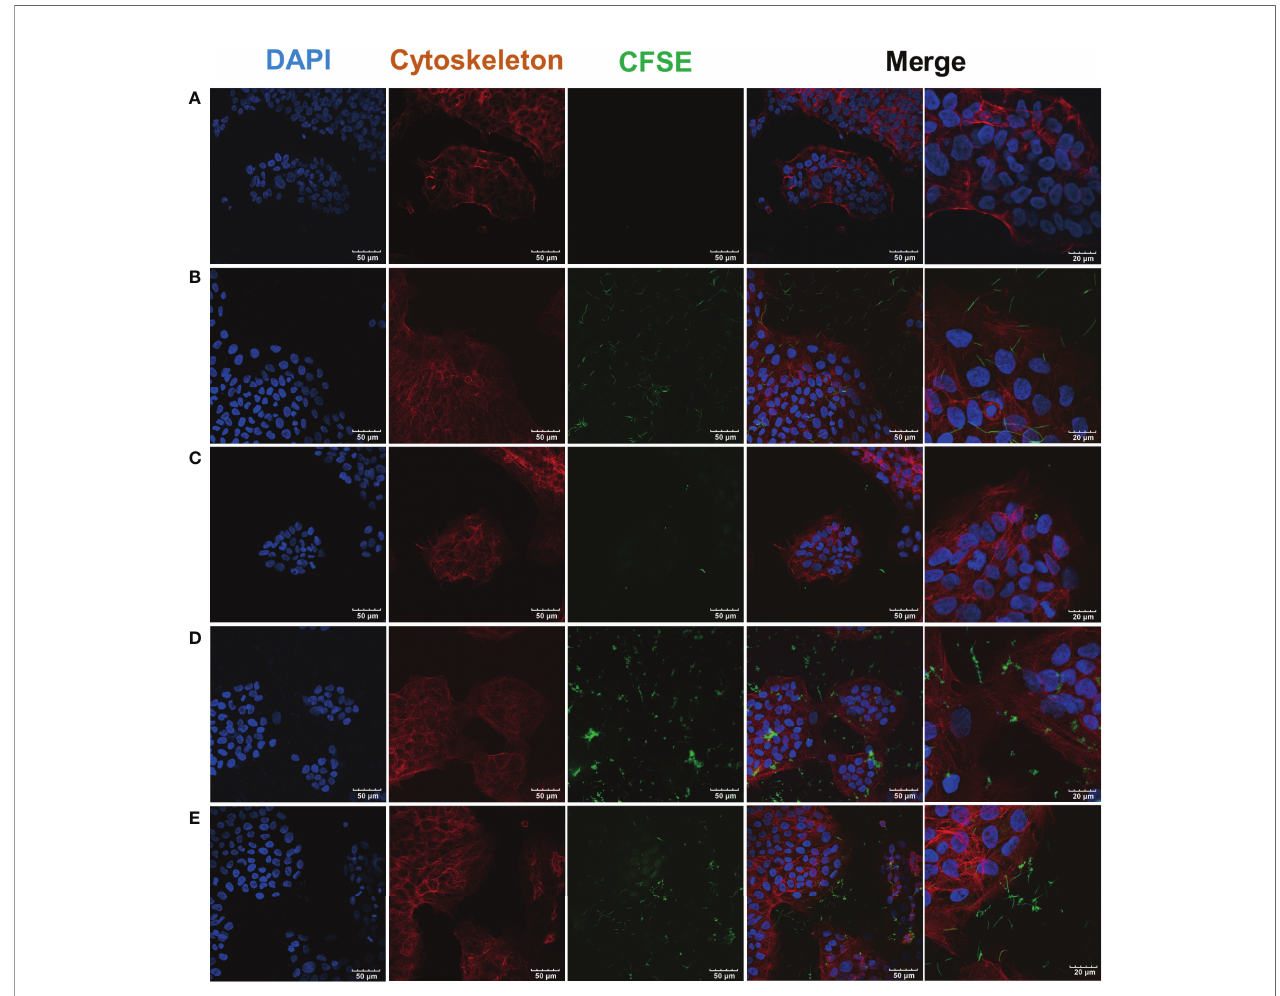
FIGURE 3 | CLSM images of F . nucleatum subsp. polymorphum and S. gordonii infection of hGECs for 4 h F. nucleatum subsp. polymorphum and S. gordonii were stained green by CFSE. The cytoskeleton was stained red by phalloidin, and the nucleus was stained blue by DAPI. (A) Blank control group. (B) F. nucleatum subsp. polymorphum monoculture group (Fnp). (C) S. gordonii monoculture group (Sg). (D) F. nucleatum subsp. polymorphum and S. gordonii coinfection group (Fnp+Sg). (E) F. nucleatum subsp. polymorphum and S. gordonii coaggregation group